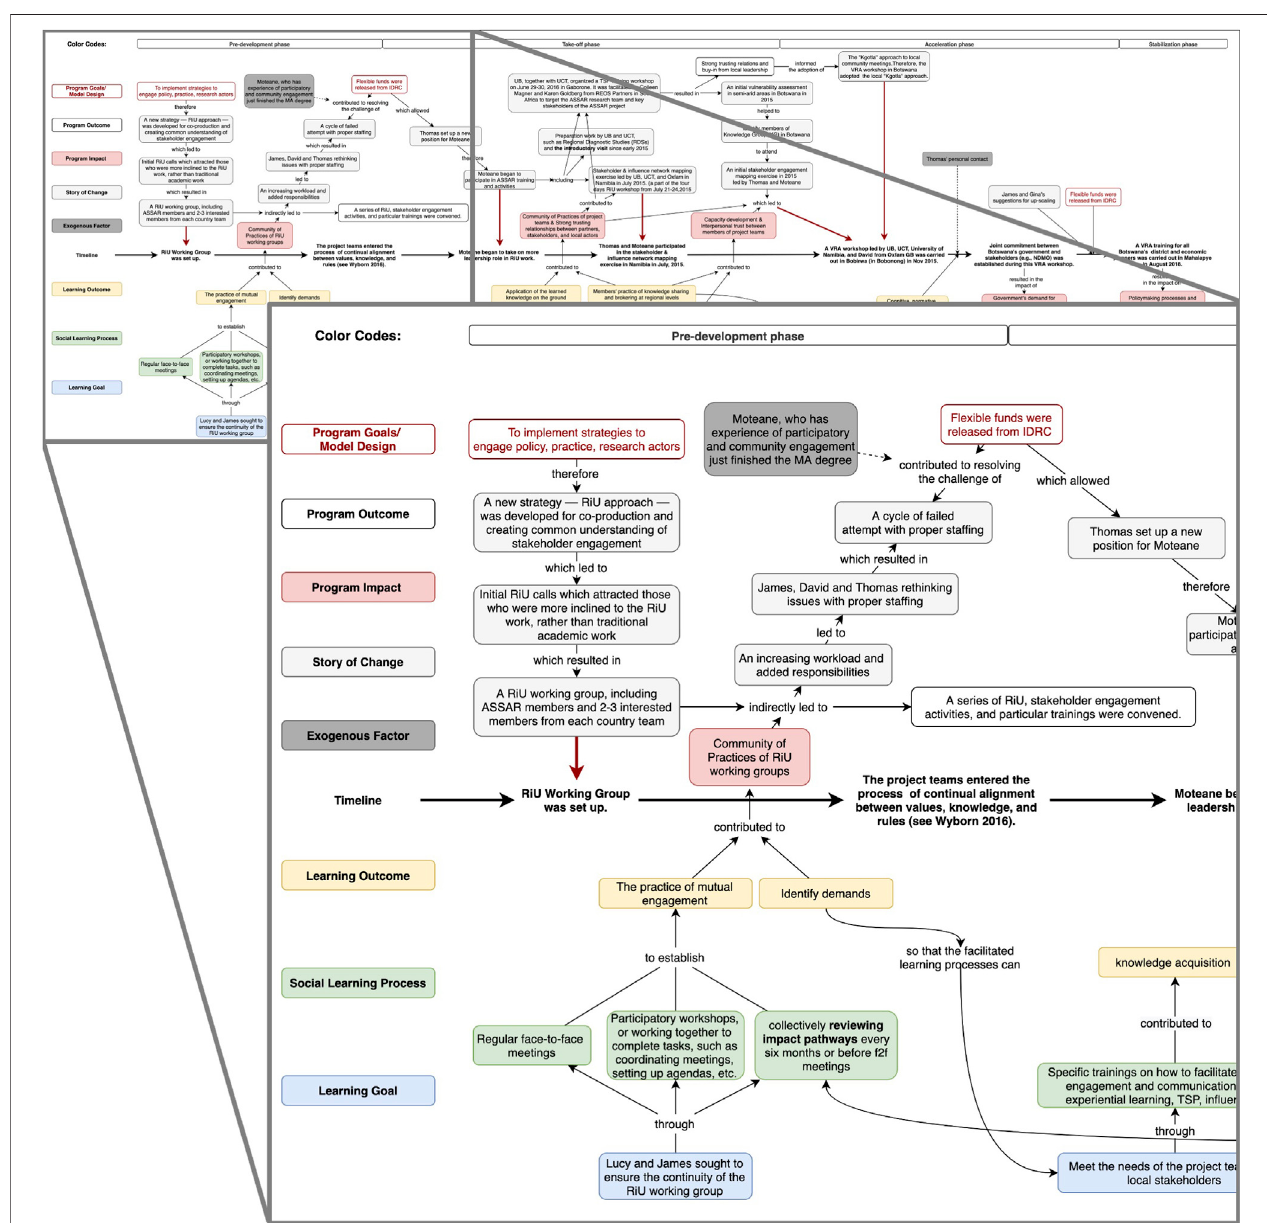
FIGURE5| Excerpt ofthe fi nalized contributionpathway. Figure 5 isasnapshotofthe fi nalizedcontribution pathway. The fullcontributionpathway ofthischange case is available at https://doi.org/10.6084/m9. fi gshare.14550840.v9. Key actors in this contribution pathway are two Oxfam-ASSAR partners (James and David), the Principal Investigator of ASSAR ’ s UB team (Thomas), and an early career researcher who later became the coordinator of ASSAR (Moteane). These are pseudonyms. The upper layer of the timeline illustrates the program implementation process for the change case in question, describing the sequence of events, outputs, outcomes and impacts that constituted the case. The bottom layer of the timeline illustrates the learning dimensions of the change process.